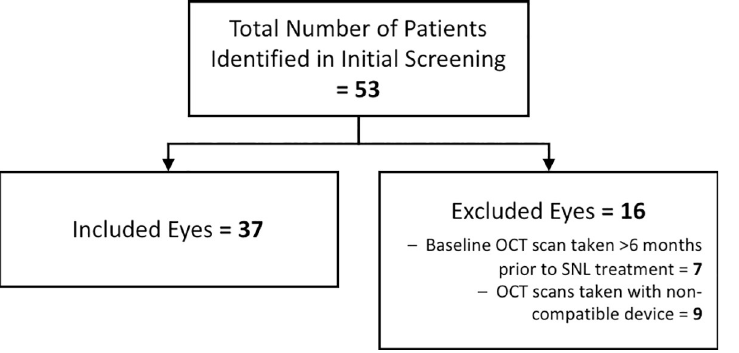
Fig 3. Flow diagram of study participants and reasons for